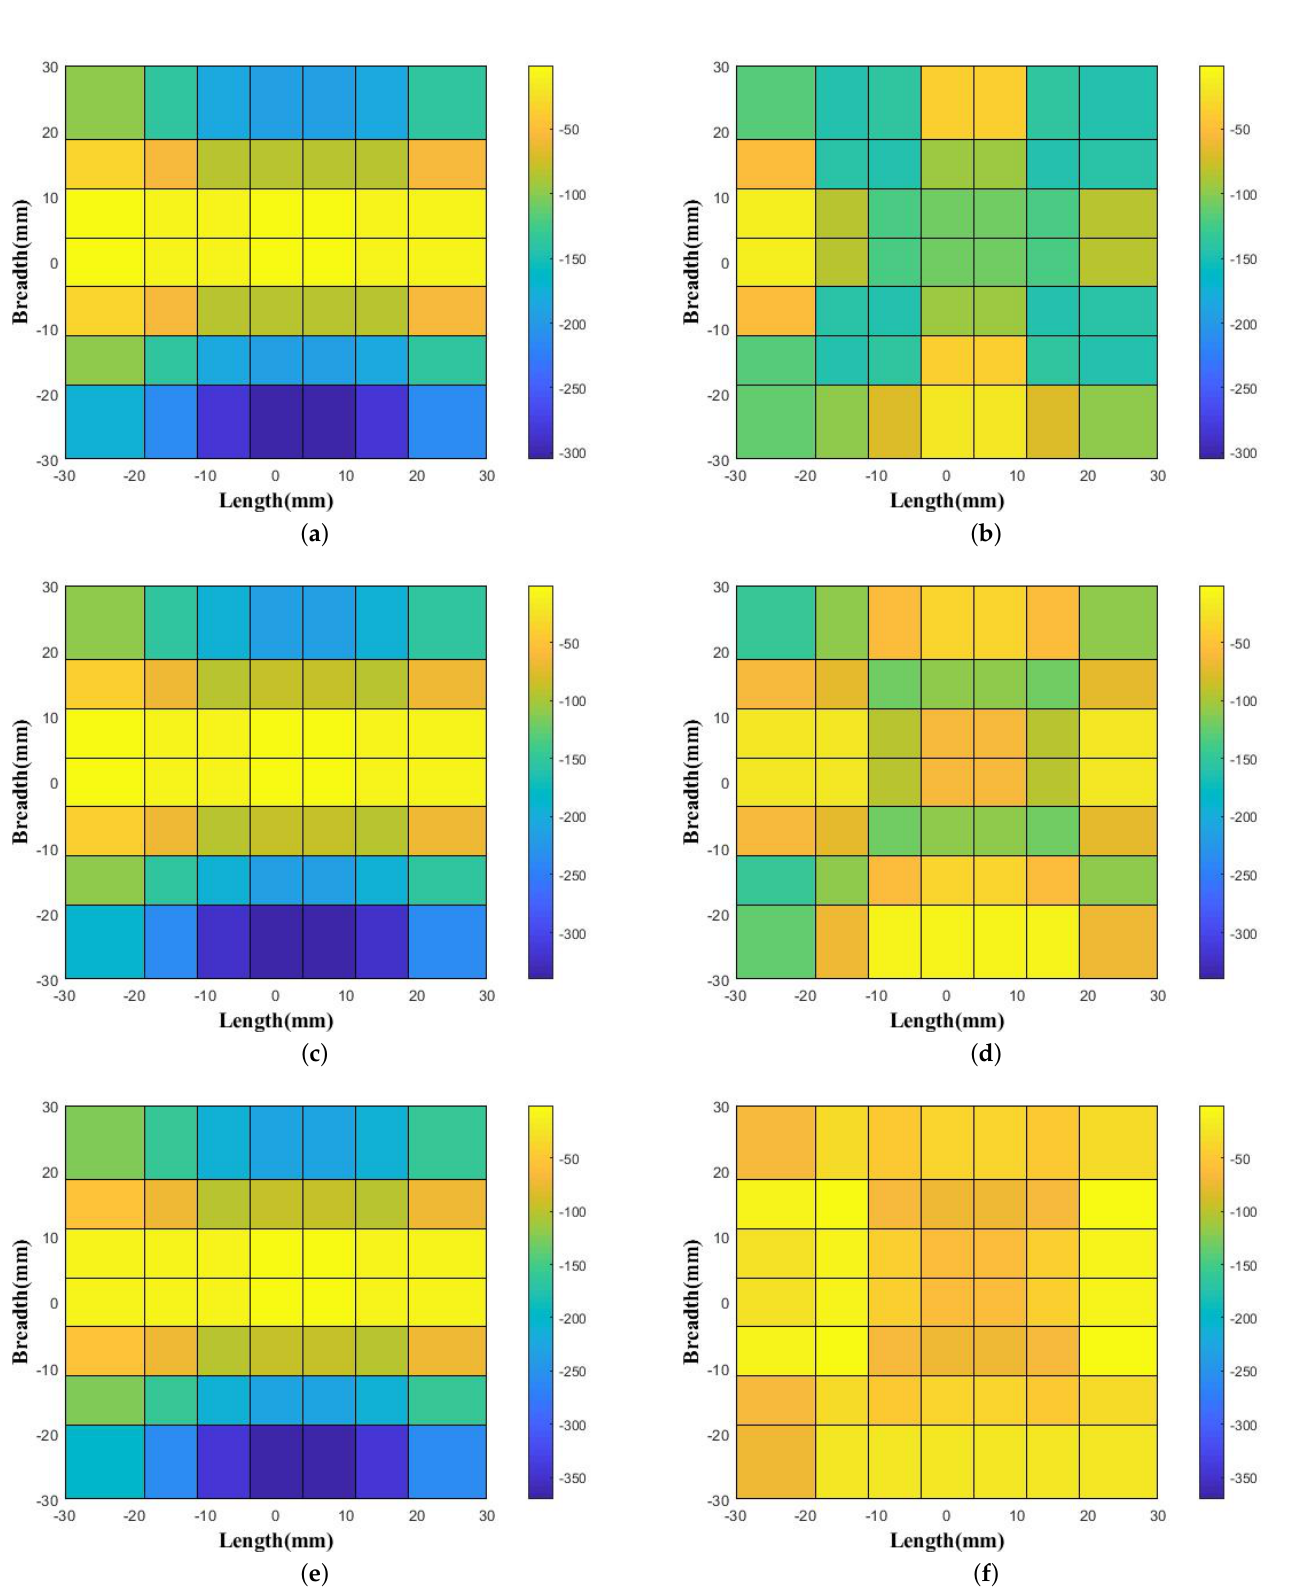
Figure 7. Obtained phase distribution noted above the feed WR-75 waveguide without the proposed prototype ( a ) at 13 GHz, ( c ) at 14 GHz, and ( e ) at 15 GHz and with the placement of the proposed prototype ( b ) at 13 GHz, ( d ) at 14 GHz, and ( f ) at 15